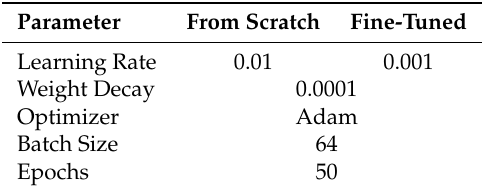
Table 3. Hyperparameters for each of the Convolutional Neural Network (CNN) models.